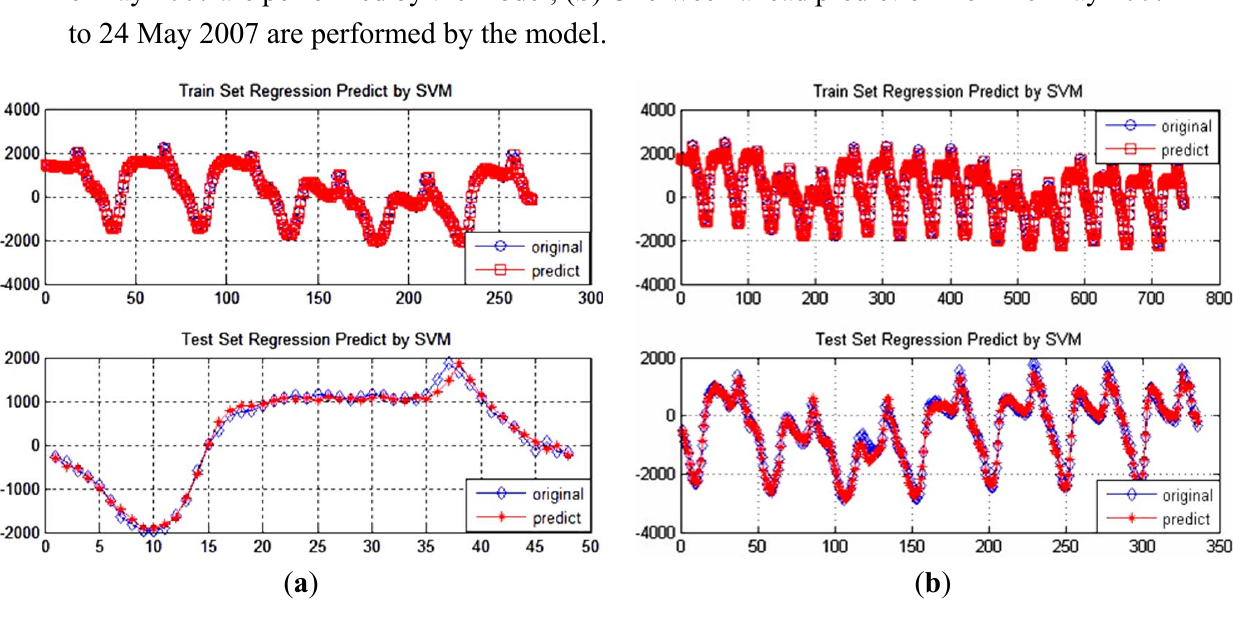
Table 1. The SVR’s parameters for data-I and